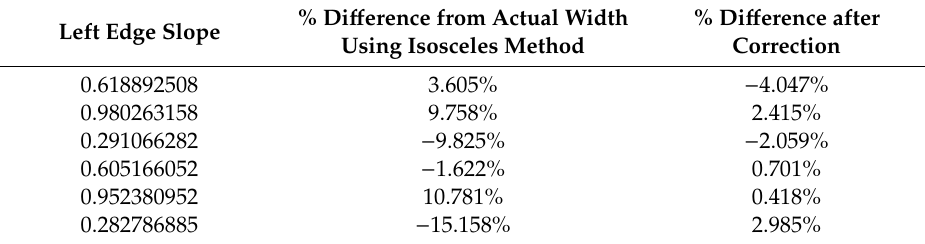
Table 2. Performance of corrected isosceles-triangle model on a test set of experimental data. Left Edge